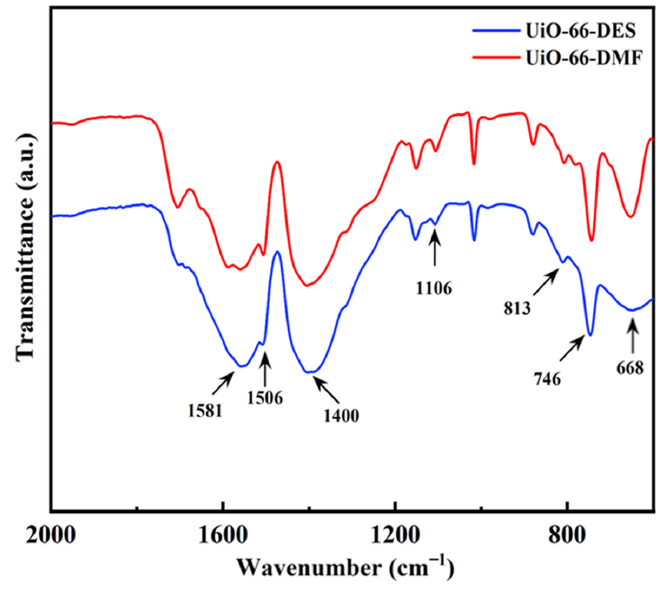
Figure 4. FT-IR spectra of UiO-66-DES and UiO-66-DMF.